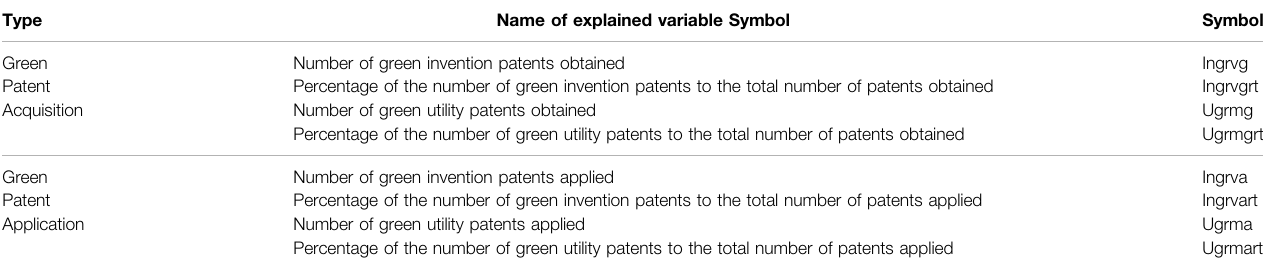
TABLE 3 | | De fi nition and description of explained